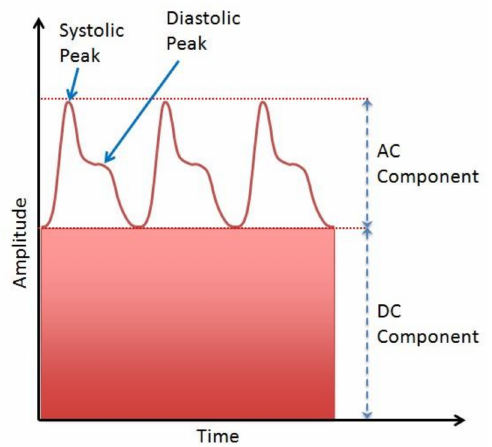
Figure 4. AC and DC components of the PPG